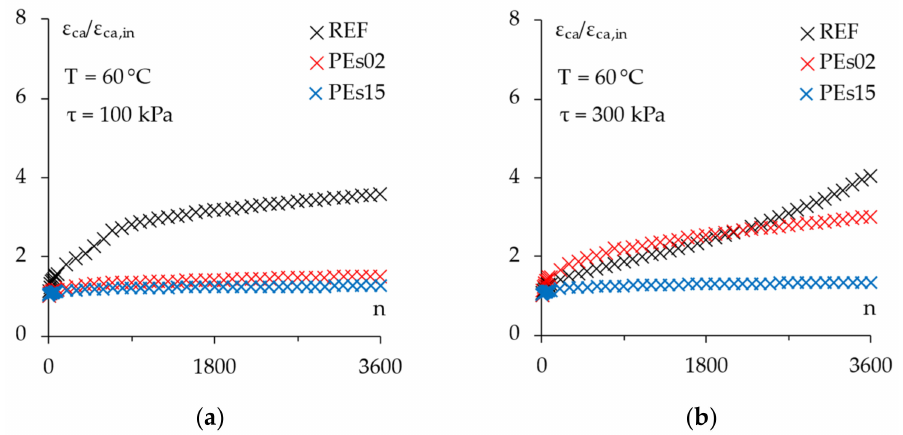
Figure 14. The CCT results. Evolution of the cumulative axial strain at: ( a ) 100 kPa; ( b ) 300 kPa. Table 9. The CCT results: initial and final cumulative axial strain and creep rate of the mixtures.